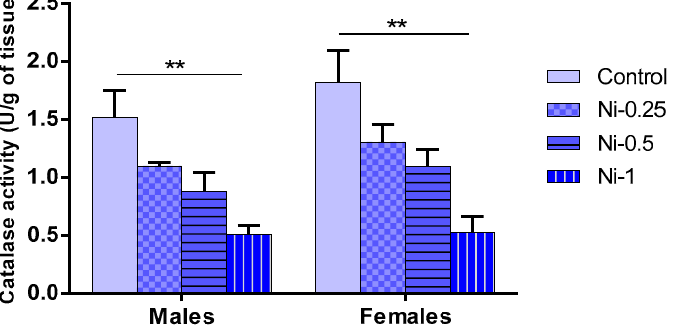
Figure 9. Changes in catalase (CAT) activity in hippocampus, expressed as U/g of hippocampal tissue in male and female rats after 8 weeks of treatment with 0.9% of NaCl (Control), 0.25 mg/kg (Ni-0.25), 0.5 mg/kg (Ni-0.5), and 1 mg/Kg (Ni-1) of Ni. Results are represented as mean ± SEM. The significance level is 0.05. ** p < 0.01.